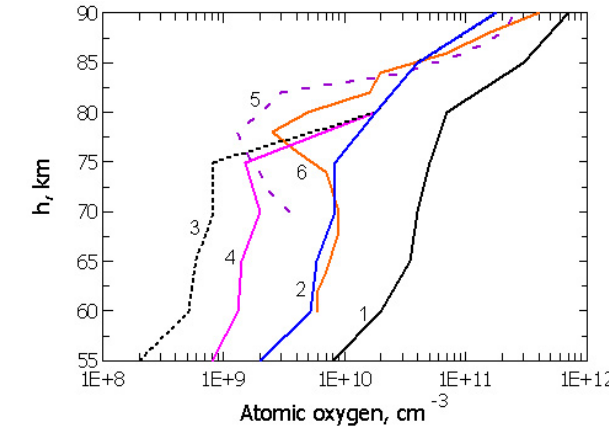
Fig. 1. Atomic oxygen profiles in the mesosphere. 1–5 are model profiles. 1 is from Shimazaki and Laird (1972); 2 is from Zadorozhny (1982); 3 and 4 are assumed for SPE conditions in the present study; 5 is for summer, noctilucent cloud conditions (Mur- ray and Plane, 2005). Profile 6 corresponds to measurements for summer noctilucent cloud conditions (Dickinson et al.,